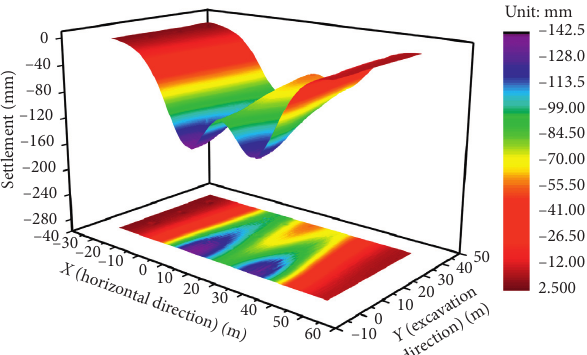
Figure 28: Surface settlement distribution after construction (without grouting).